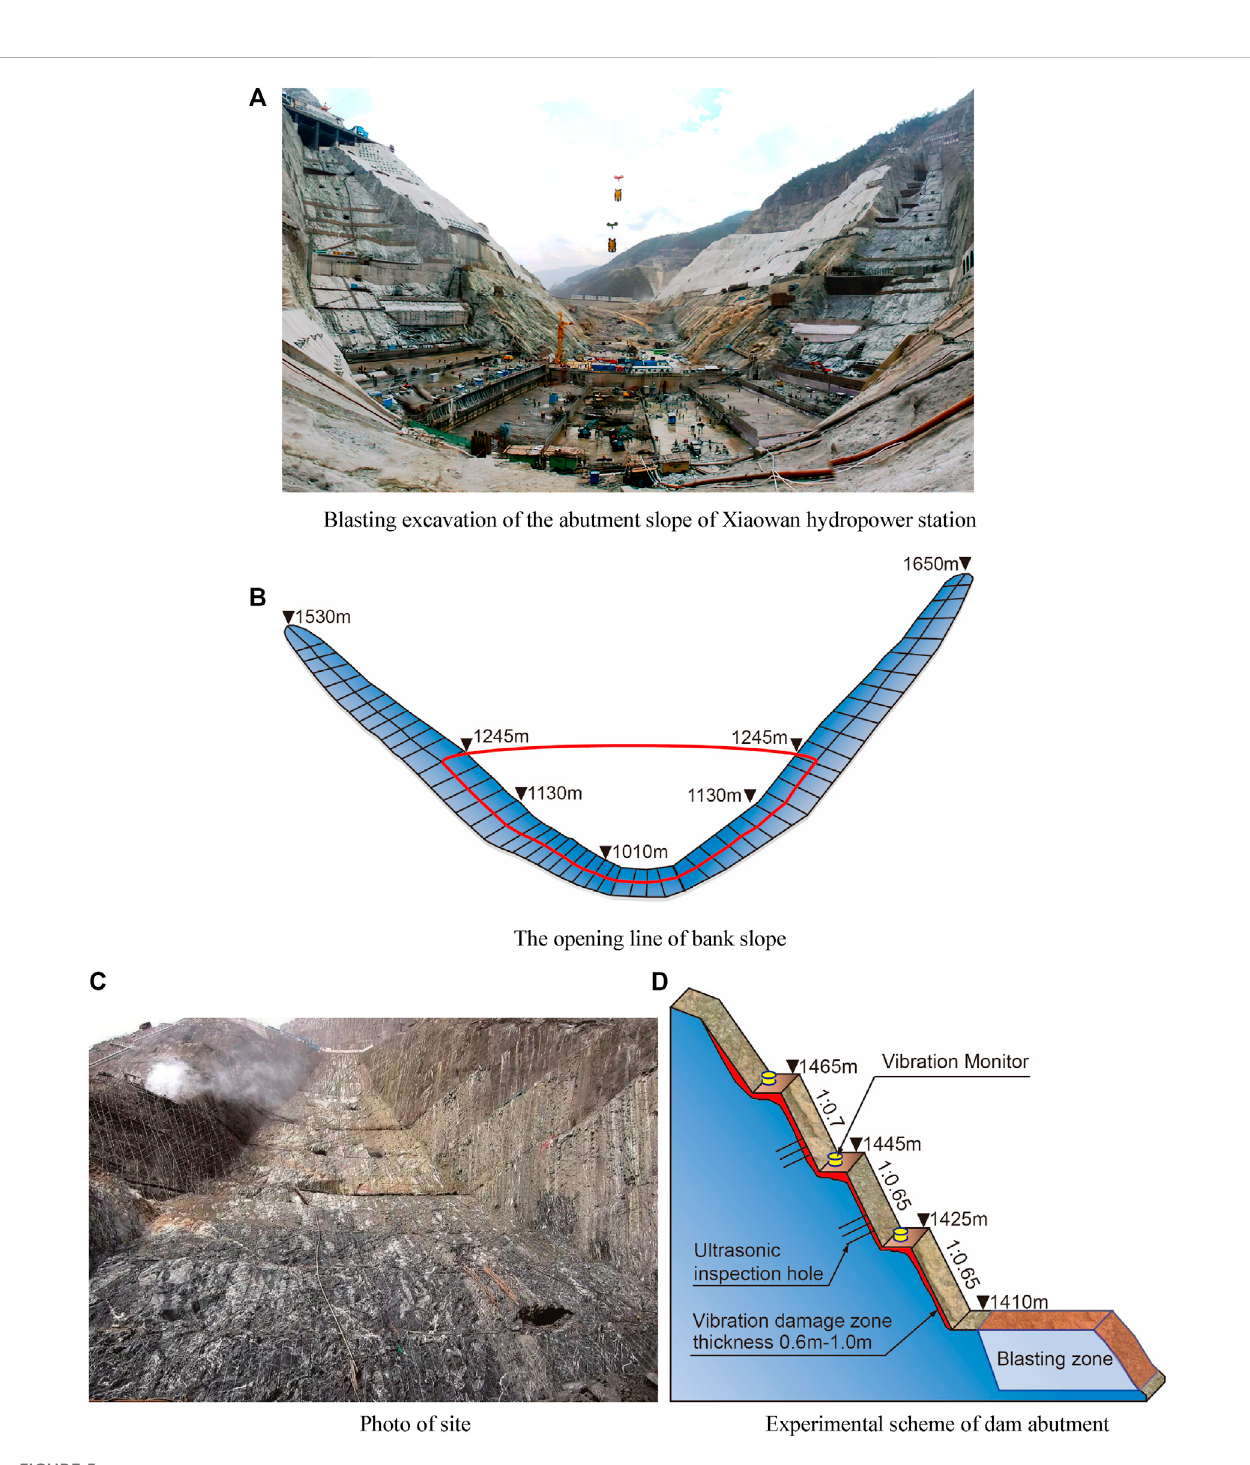
FIGURE 5 Blasting excavation and experimental scheme of dam abutment of Xiaowan Hydropower Station (A) Blasting excavation of the abutment slope of Xiaowan hydropower station (B) The opening line of bank slope (C) Photo of site (D) Experimental scheme of dam abutment.